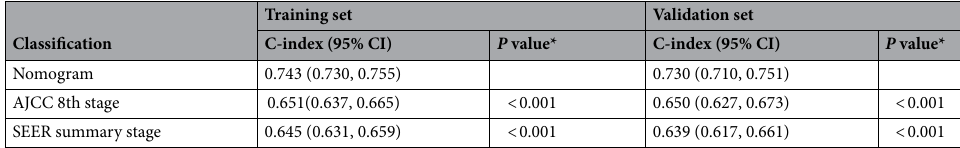
Table 3. C-indexes for the nomogram and other stage systems in patients with colorectal signet ring cell carcinoma. *All are compared with Nomogram, HR hazard ratio, CI confidence interval.